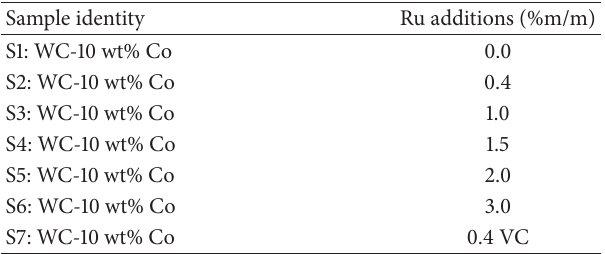
Table 1: The chemical composition of the samples. Sample